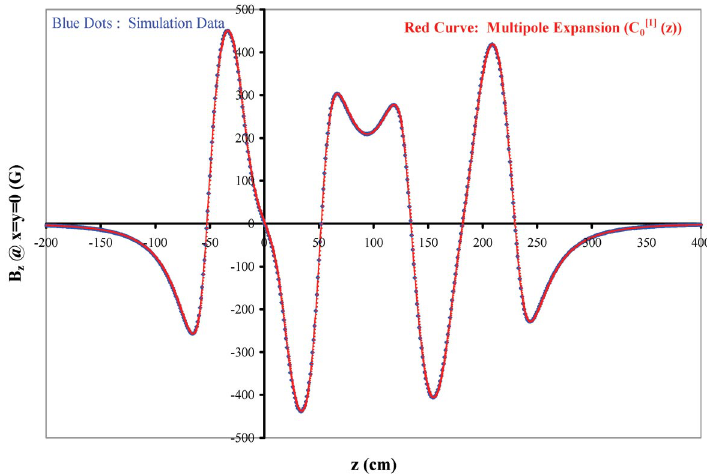
.FIG. FIG. 13. (Color) B FIG. 14. (Color) B